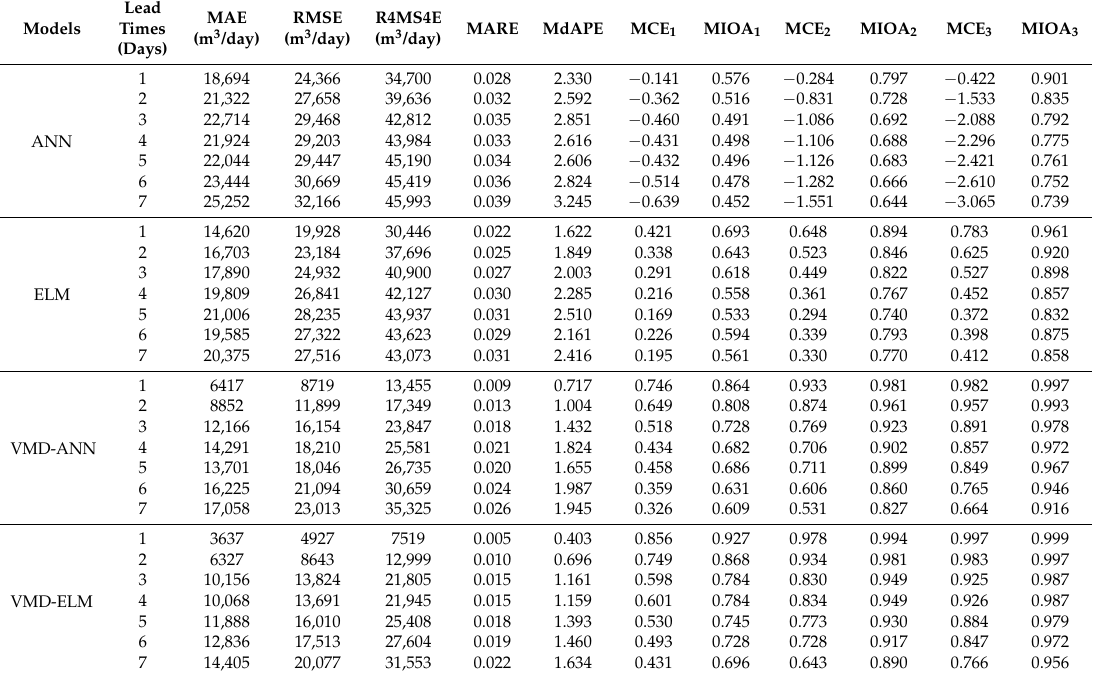
Table 3. Performance evaluation for testing